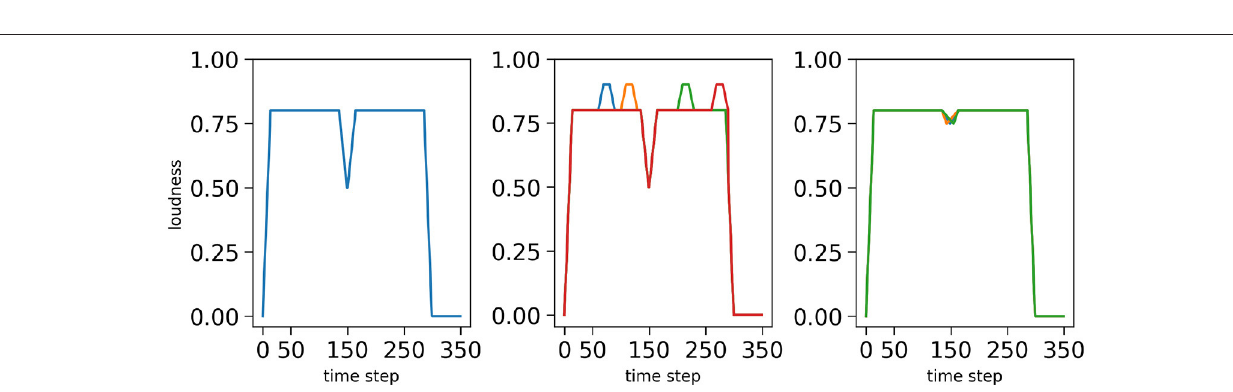
FIGURE 5 | Loudness profiles for the bi-syllabic word “ pata ” used in the three simulation conditions: the nominal condition (left) , the “noisy-event” condition (middle) and the “hypo-articulation-event” condition (right) . Simulated time is on x -axes, normalized loudness (arbitrary units) is on y -axes. Degraded conditions (middle, right) , respectively correspond to the first noise level with one spurious event in a random position in the “noisy-event” condition, and to a dip value at 0.75 with random dip shapes in the “hypo-articulation-event” condition. The different colors correspond to different random